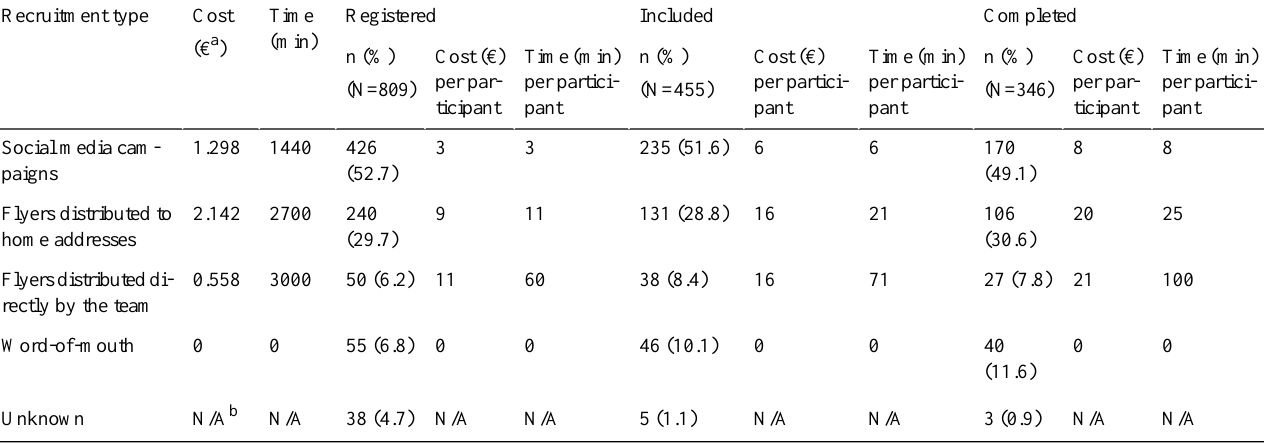
Table 1. The cost, time, and percentage of participants in each recruitment strategy during three phases of the study. CompletedIncludedRegisteredTime (min)Cost